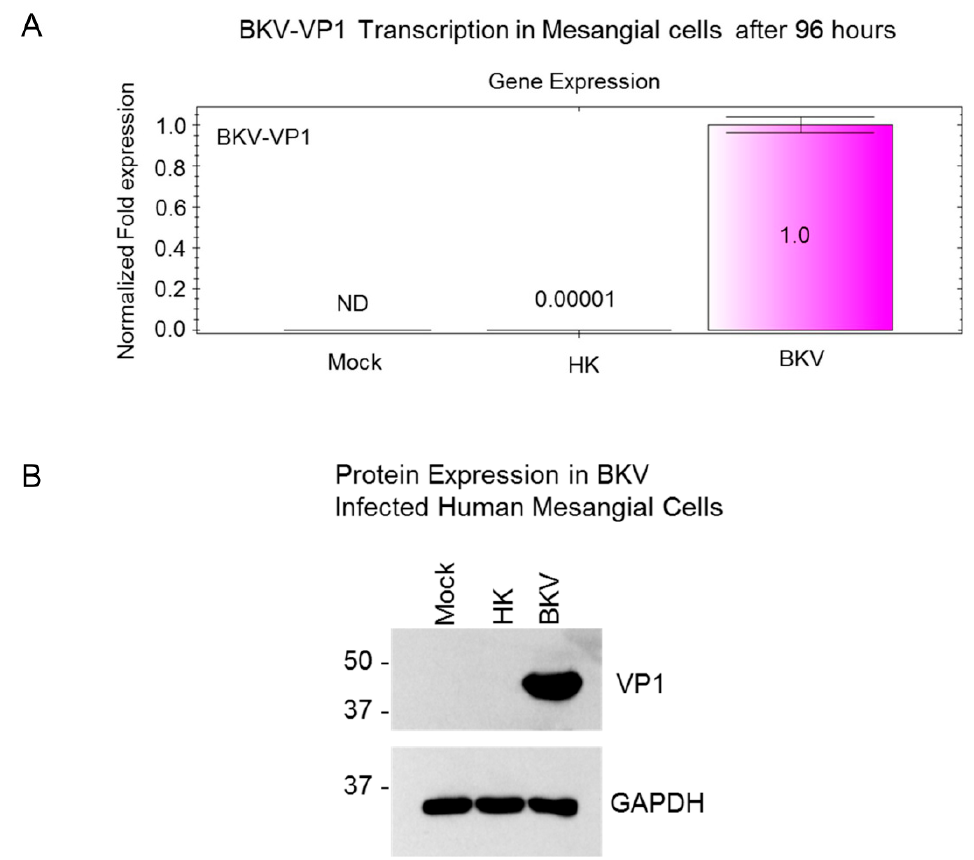
Figure 4. VP1 Expression in BKV-Infected mesangial cells. ( A ) qRT-PCR analysis of VP1 transcripts in mock-infected mesangial cells or cells exposed to heat-killed (HK) BKV or infected with wild-type BKV for 96 h. qRT-PCR results were normalized to GAPDH. ( B ) Western blot analysis of BKV VP1 expression in mesangial cells mock-infected or exposed to heat-killed or wild-type BKV for 96 h. Protein size markers are shown in kilodaltons. GAPDH is used as a protein loading control.